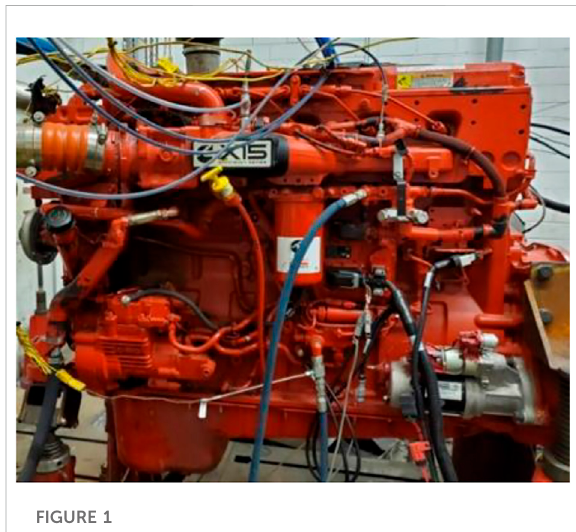
FIGURE 1 Cummins X15 engine platform installed in the test